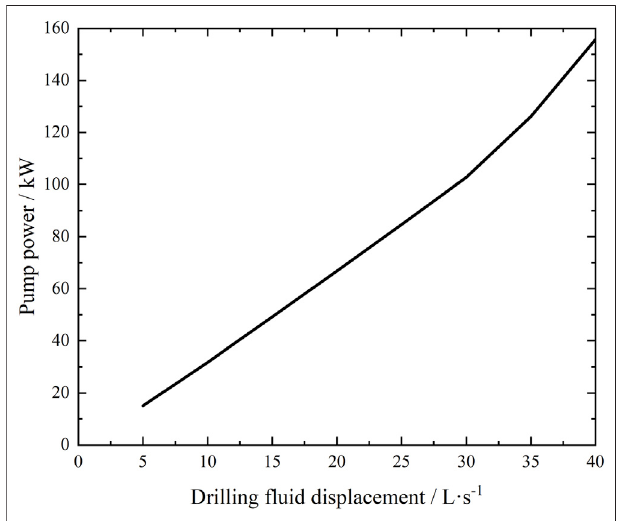
FIGURE 5 | Effect of drilling fl uid displacement on the gas volume fraction inside the return pipeline.